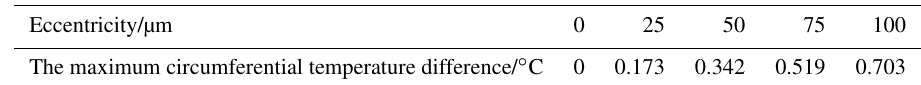
Figure 14. The influence of air-gap eccentricity at 2000rpm on the temperature field of the stator rotor. Table 3. The circumferential maximum temperature difference of the stator under different air-gap